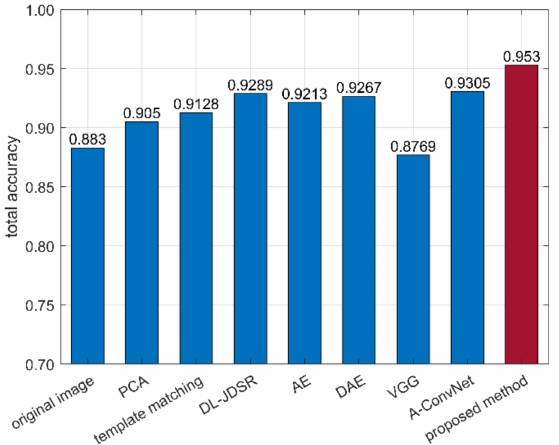
Figure 10. Ten-target accuracy on civilian vehicle data obtained by different SAR target recogni- tion